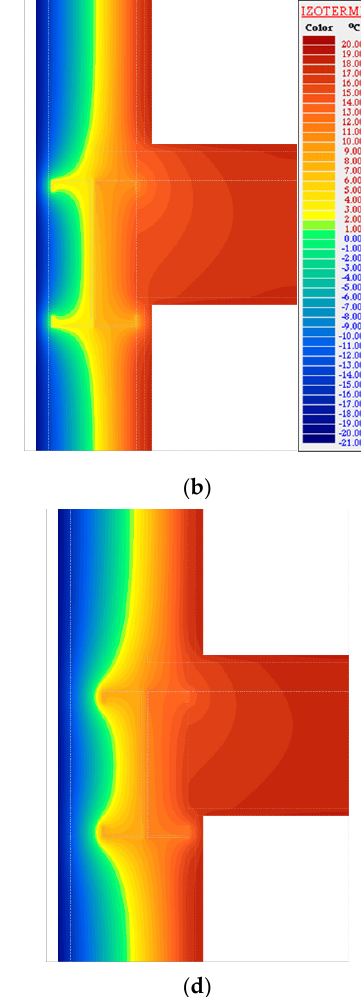
Figure A7. Exterior wall-intermediate floor-Geometrical models ( a ) E-W wall ( c ) N wall; Isothermal surfaces ( b ) E-W wall ( d ) N wall.